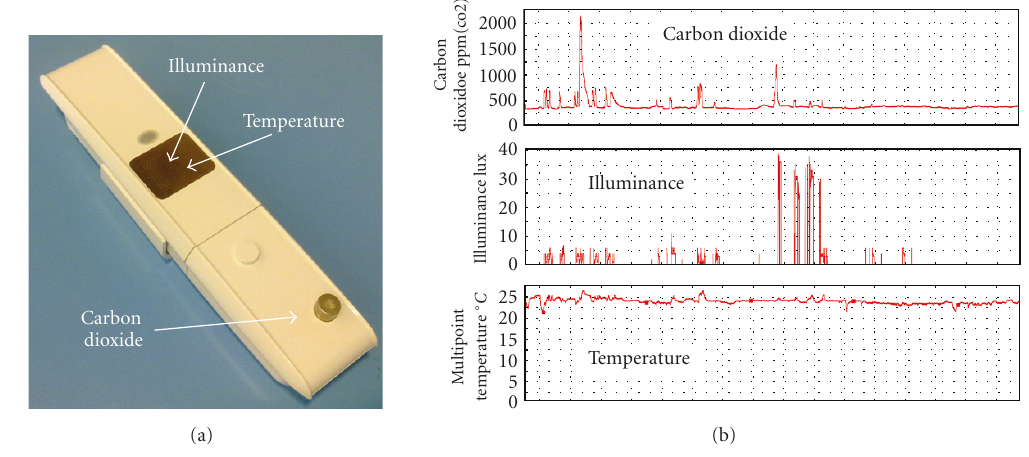
Figure 19: Examples of possible measurements using the hospital security